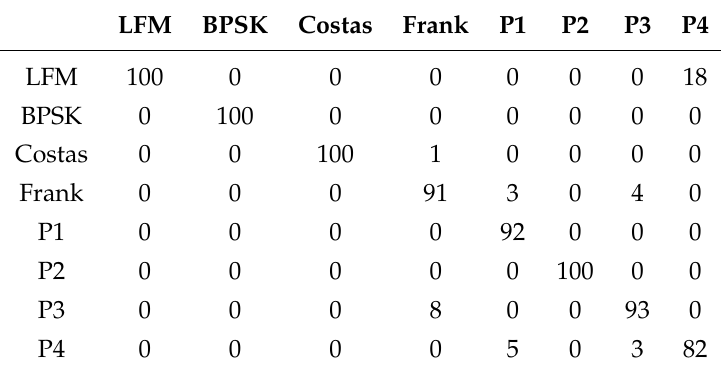
Table 3. Confusion matrix for the system at signal-to-noise ratio (SNR) of − 2 dB. The overall ratio of successful recognition (RSR) is 94.7%.